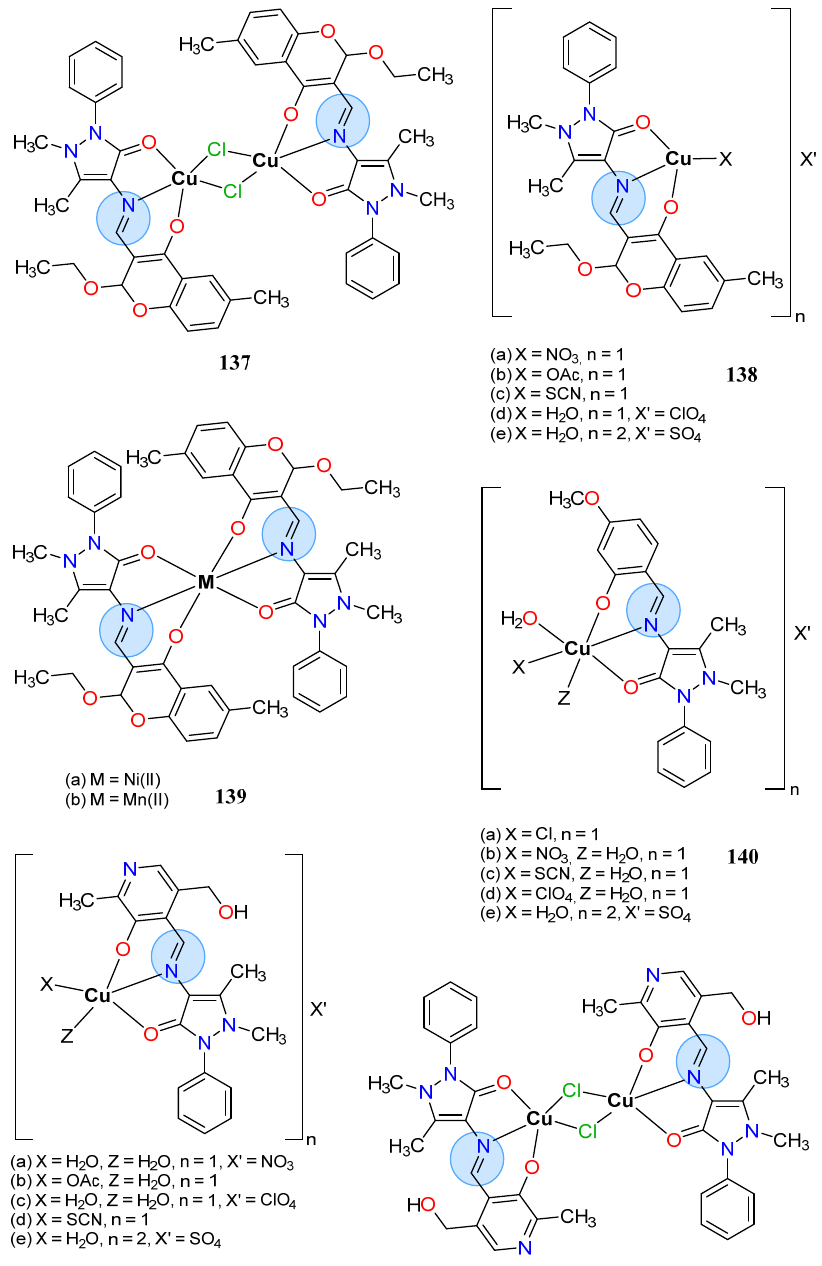
Figure 68. Transition metal complexes with Schiff base ligands derived from antipyrine studied for their antibacterial activity.